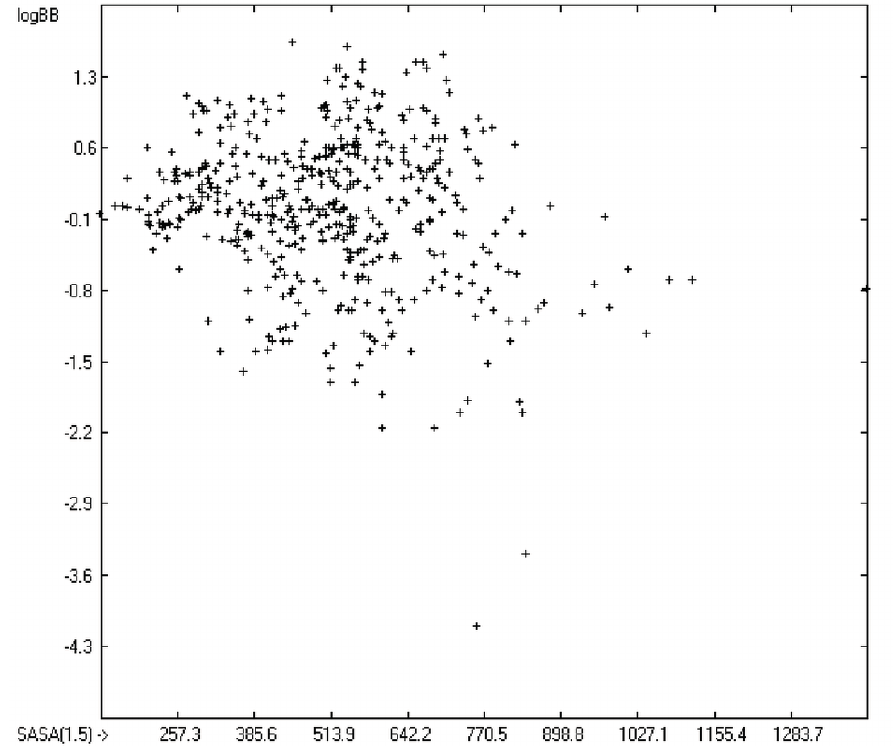
Figure 20. Correlation diagram of polar surface area (PSA) against logBB (N = 438, R 2 = 0.3335).